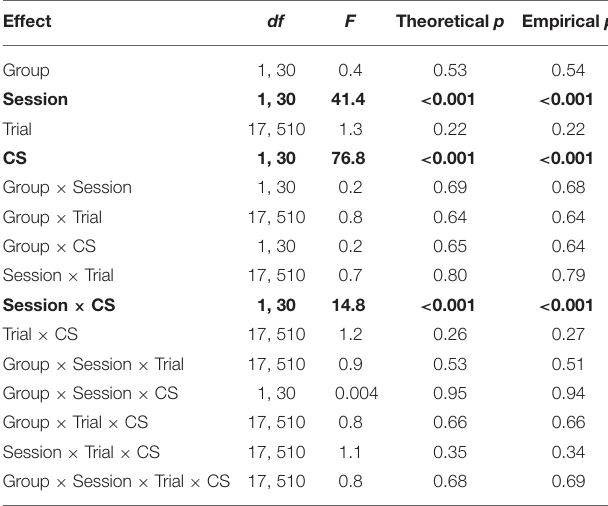
TABLE 1 | ANOVA of CS vs. pre-CS drinking time (fear of tone vs. context) during extinction learning.